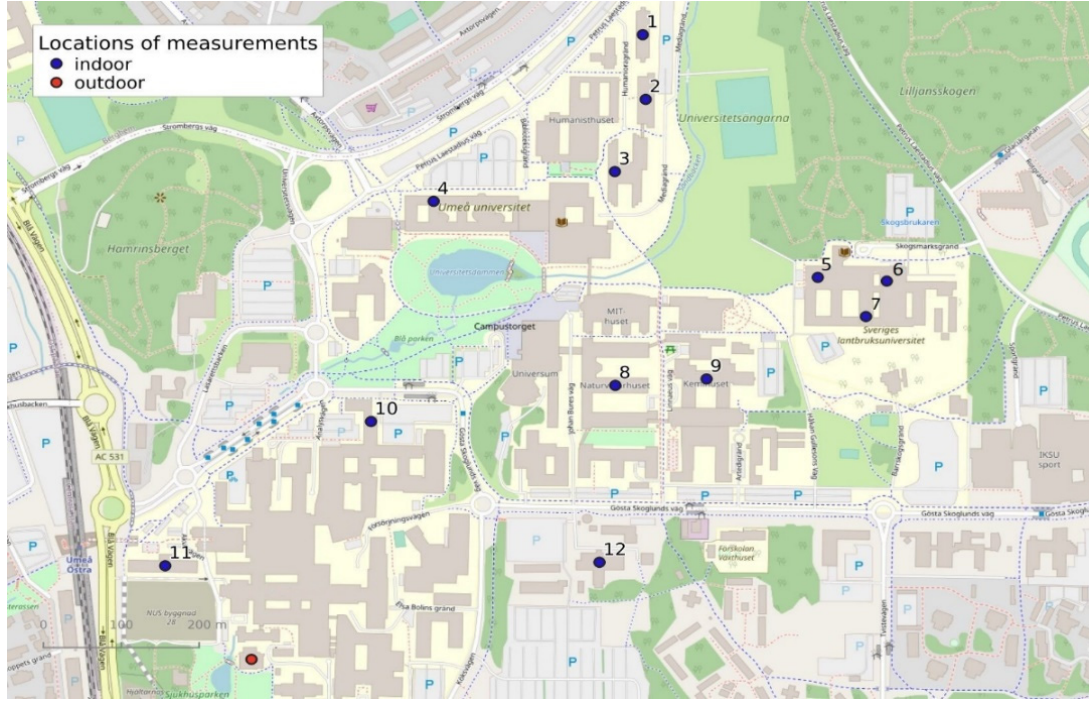
Figure 1. Study area with the locations of Buildings 1–12, where indoor measurements were carried out (blue circles). The outdoor measurements were carried out at the red circle. Basemap: © OpenStreetMap contributors. Table 1. Technical characteristics of the buildings. Mechanical ventilation with heat recovery (MVHR) is used in all